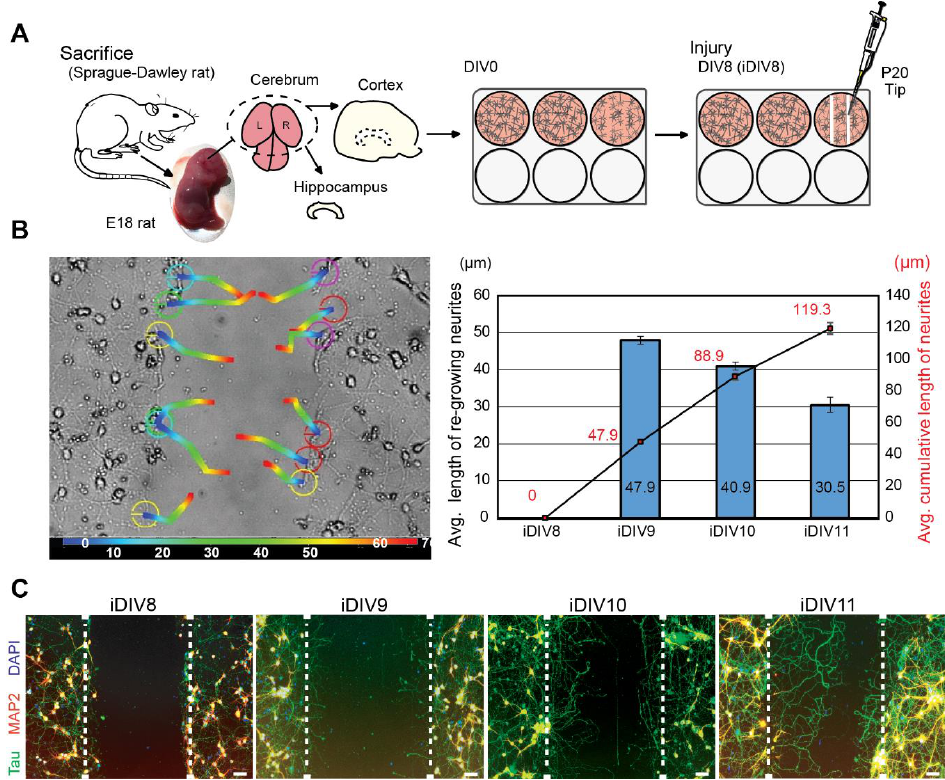
Figure 1. Neurite re-growth of primary cortical neurons in an in vitro traumatic brain injury (TBI) model. ( A ) Schematic flow chart of experimental design. ( B ) Trajectory of single neurite re-growth was tracked from 0 h (blue) to 72 h (red) after injury using tracking function of AxioVision software (left). Quantitative results of average length of re-growing neurite (blue bars) and average cumulative length (line graph) are shown from iDIV8 to iDIV11 (right). ( n = 3, track 12 neurites/experiment.) ( C ) Cortical neurons were fixed on iDIV8 to iDIV11 and were subjected to immunofluorescence staining with anti-Tau (green, axonal marker), anti-MAP2 (red, dendritic marker) antibodies, and DAPI (blue, nuclei). Merged images are shown. White dashed lines indicate the borders of the injured gap. Scale bar, 50 µ